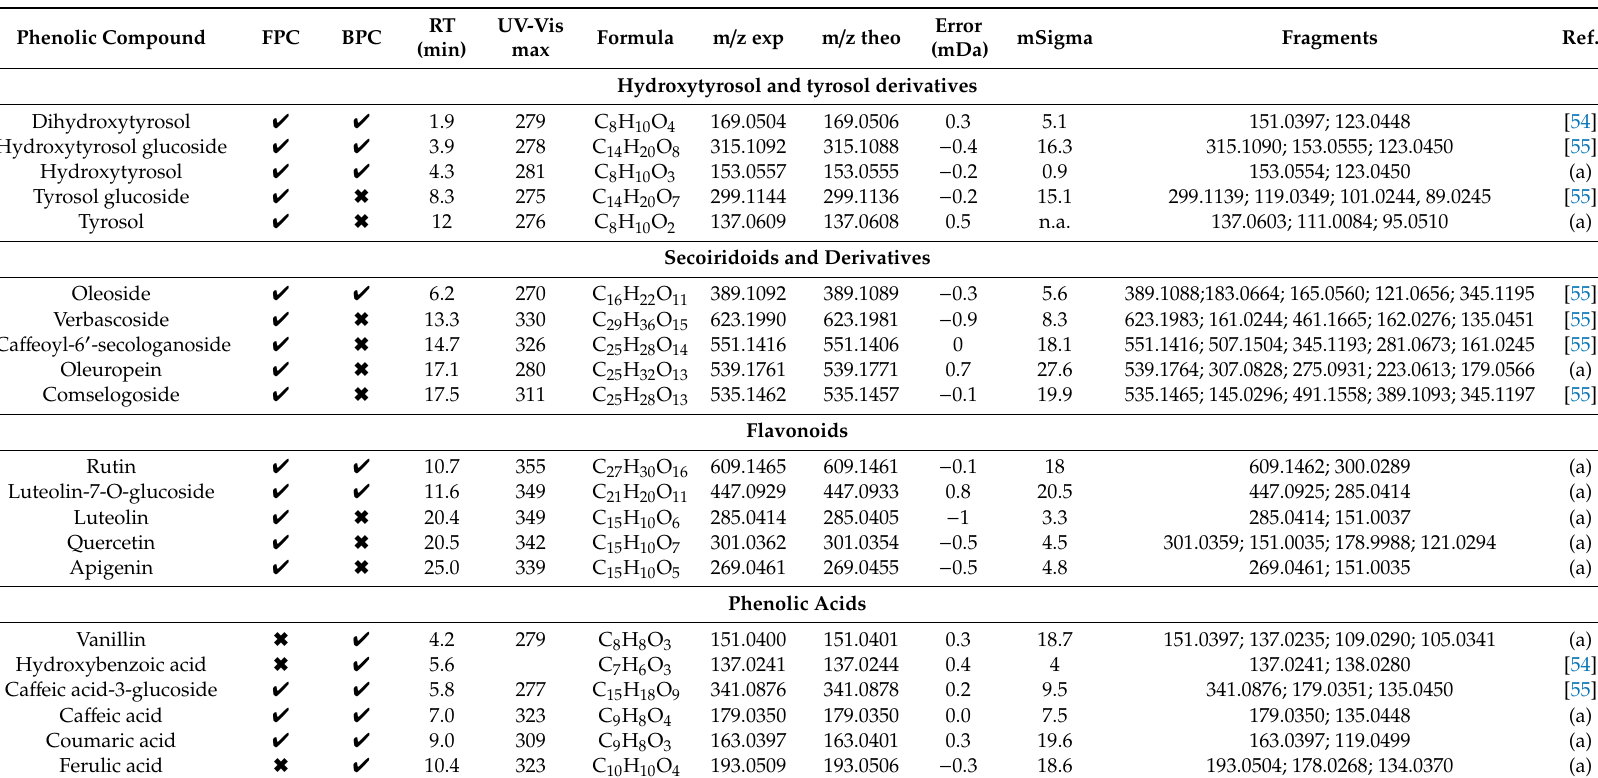
Table 2. Phenolic compounds identified (or tentatively identified) in free (FPC) and bound phenolic (BPC) extract crude olive pomace (C-OP) and edible olive pomace fractions (L-OP and P-OP) produced after the wet and dry fractionation process. Phenolic